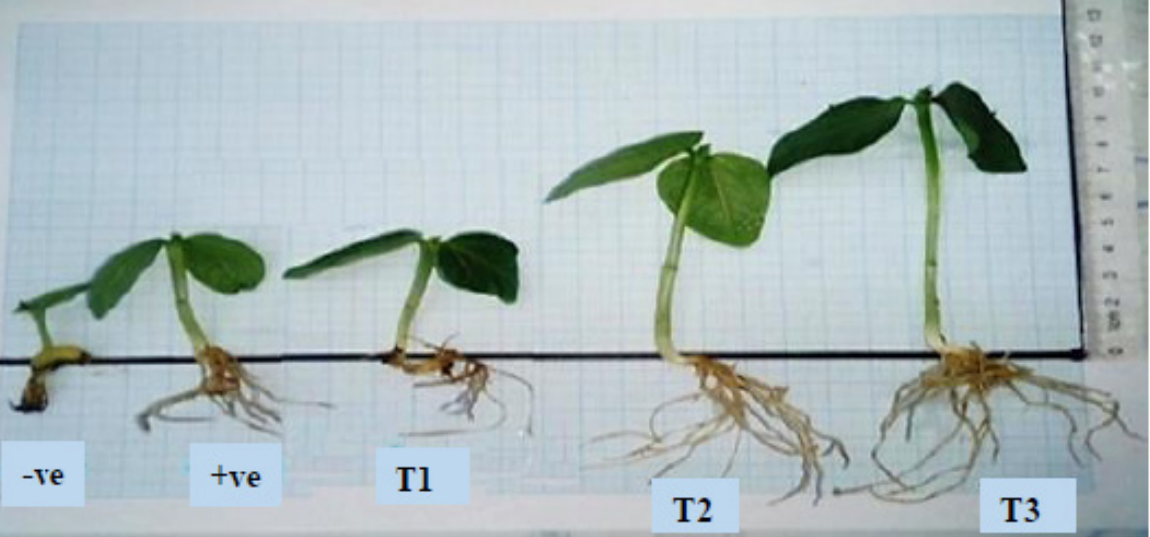
Figure 7. Cytotoxicity test for the water effluents produced after MG removal using different biosorbent treatments on V. radiate seedlings; -ve control (MG); +ve control (H Treatment 2= S. platensis culture biosorbent, and Treatment 3= S. platensis culture +TiO